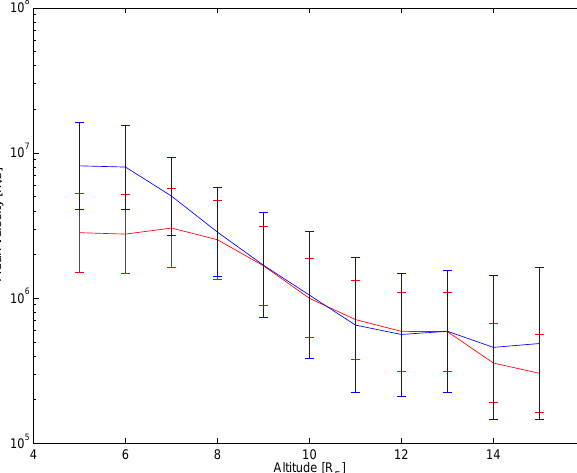
mean E/B [log m/s] (red) for each altitude. The blue and red error